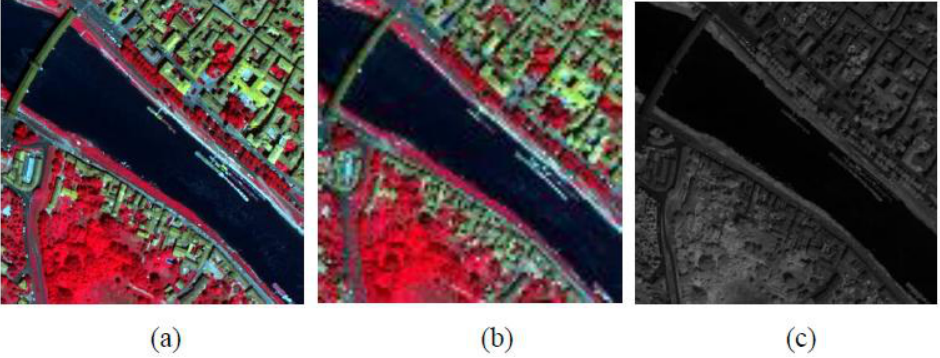
Figure 11. Pavia data set ( a ) RGB composites of Data set 2 (bands 102, 56, and 31 for red, green, and blue, respectively); ( b ) Simulated coarse image ( S = 2); ( c ) Panchromatic image.